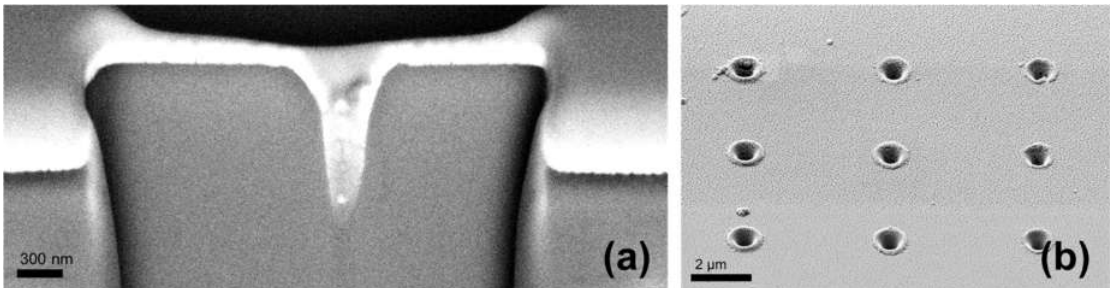
Figure 1. ( a ) SEM micrograph of a nano-hole generated by an asymmetric TOD pulse. The nano-hole has a conical shape with depth of around 1500 nm and radius of around 300 nm. The later deposited material is filled inside the hole leaving a crater on the surface [26,27]. ( b ) SEM micrograph of a nano-hole array generated by an asymmetric TOD pulse [1].